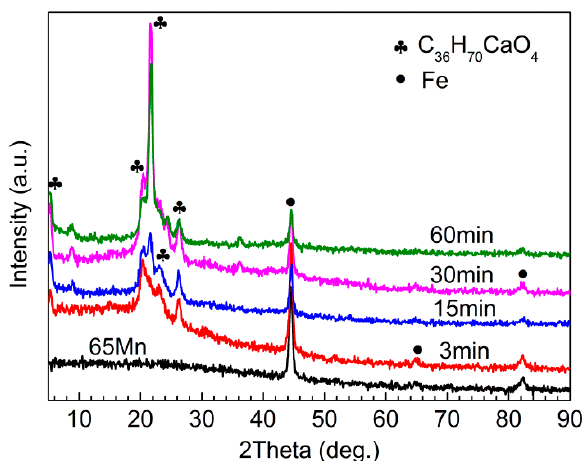
Figure 1. XRD of the bare 65Mn substrate and coatings prepared at 80 V for the different deposi- tion